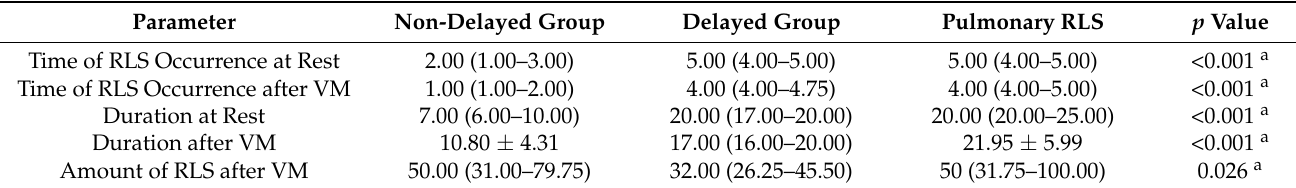
Table 2. Characteristics of RLS on cTTE.